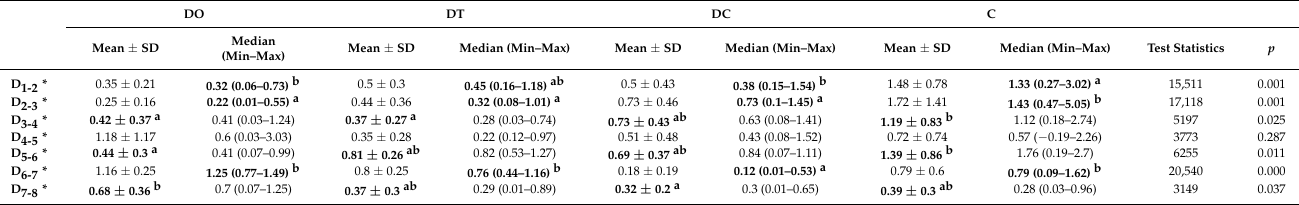
Table 1. Distance deviations of each impression group between adjacent implants.